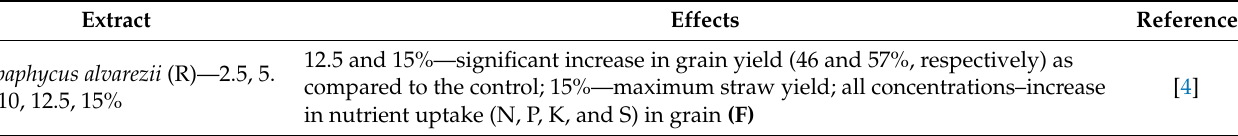
Table 1. The effects of macroalgal extracts on soybean